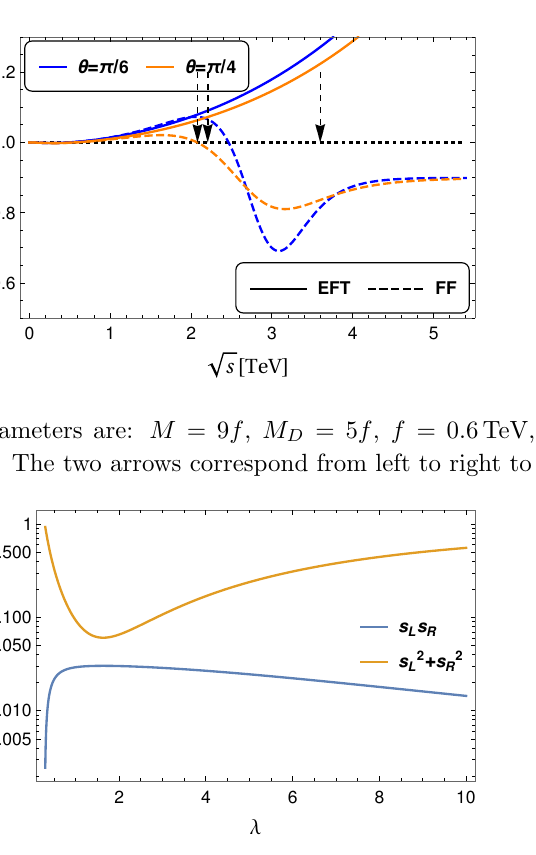
+ s 2 ) and F 2 ( s L s R L R